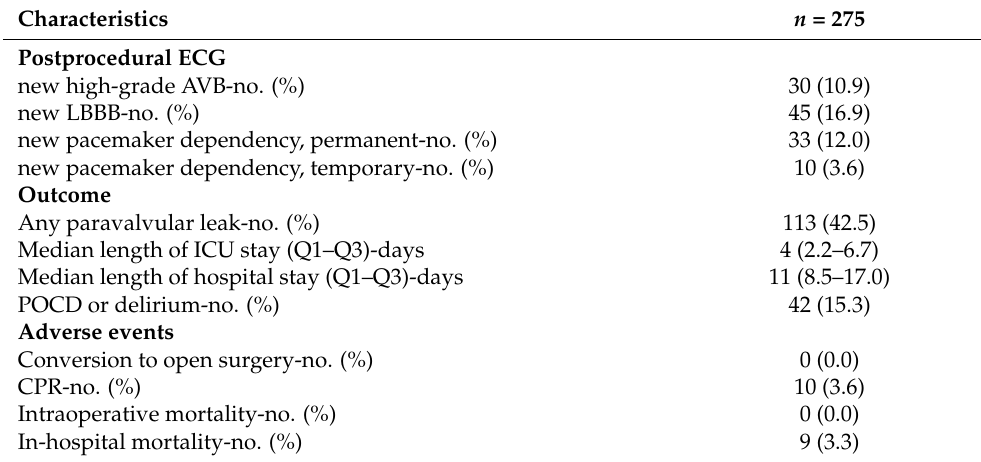
Table 2. Adverse events, postprocedural ECG and outcome.